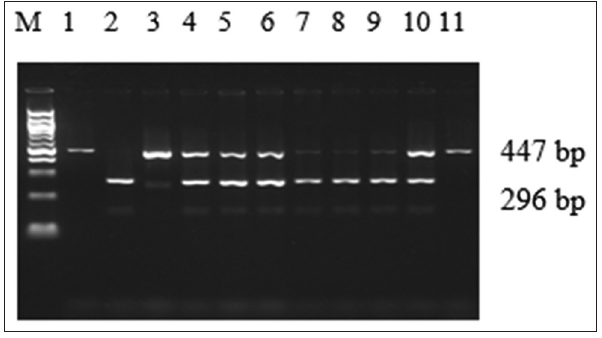
Figure-2: Modified polymerase chain reaction for Helicobacter pullorum and Campylobacter spp. Lane M - marker 100 bp ladder; lanes: 1 - H. pullorum ATCC 51863, 2 - Campylobacter jejuni ATCC 24928, 3 - H. pullorum CCUG 33837, 4-6 mixed isolates from fly samples, 7-9 mixed isolates from floor samples, 10 - mixed isolate from broiler samples, 11 - H. pullorum ATCC 51863. Table-1: Occurrence of H. pullorum in broiler chickens in 10 farms.